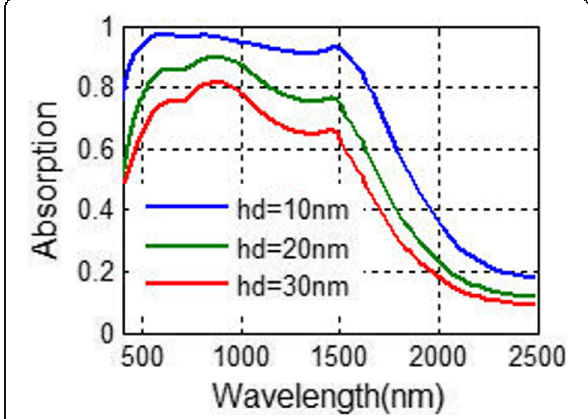
Fig. 8 Absorbing spectra of the eight-MD-pair FMA varying with the metal thickness hd. The dielectric layer thickness hh is set as 100